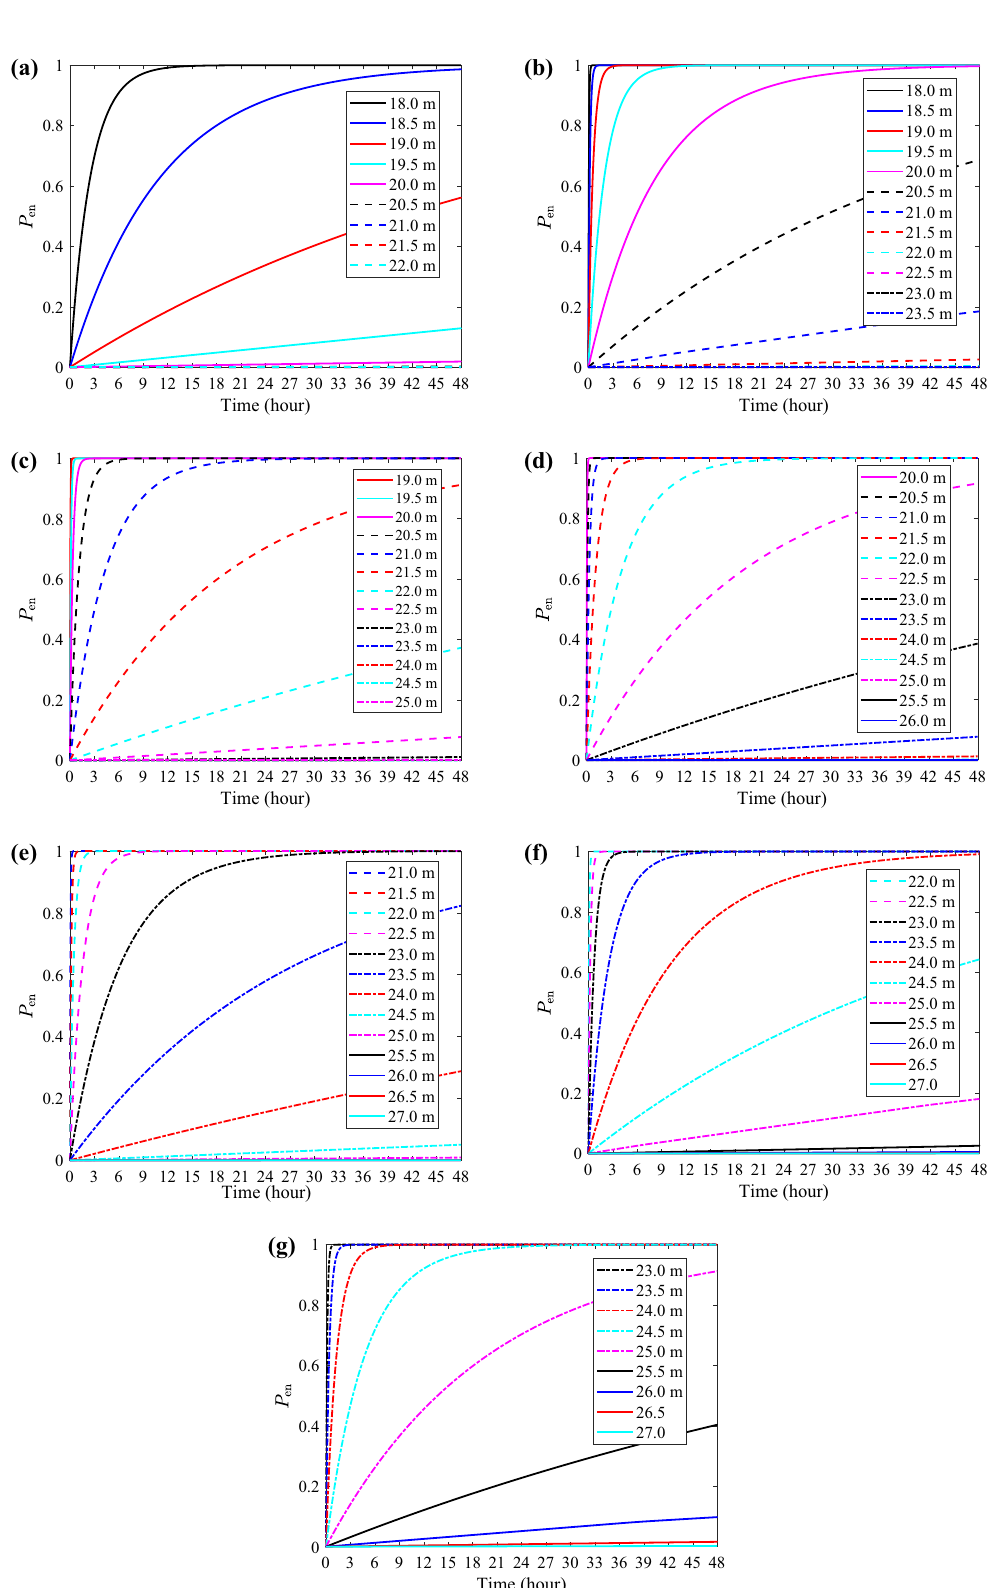
Figure 14. Probability of encroachment with varied clearances: ( a ) V 10 = 30 m/s; ( b ) V 10 = 35 m/s; ( c ) V 10 = 40 m/s; ( d ) V 10 = 45 m/s. ( e ) V 10 = 50 m/s; ( f ) V 10 = 55 m/s; ( g ) V 10 = 60